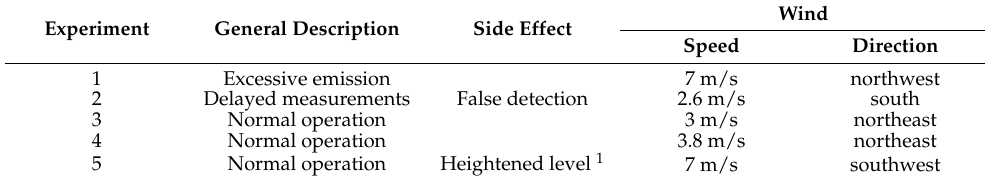
Table 5. Properties of experiments.